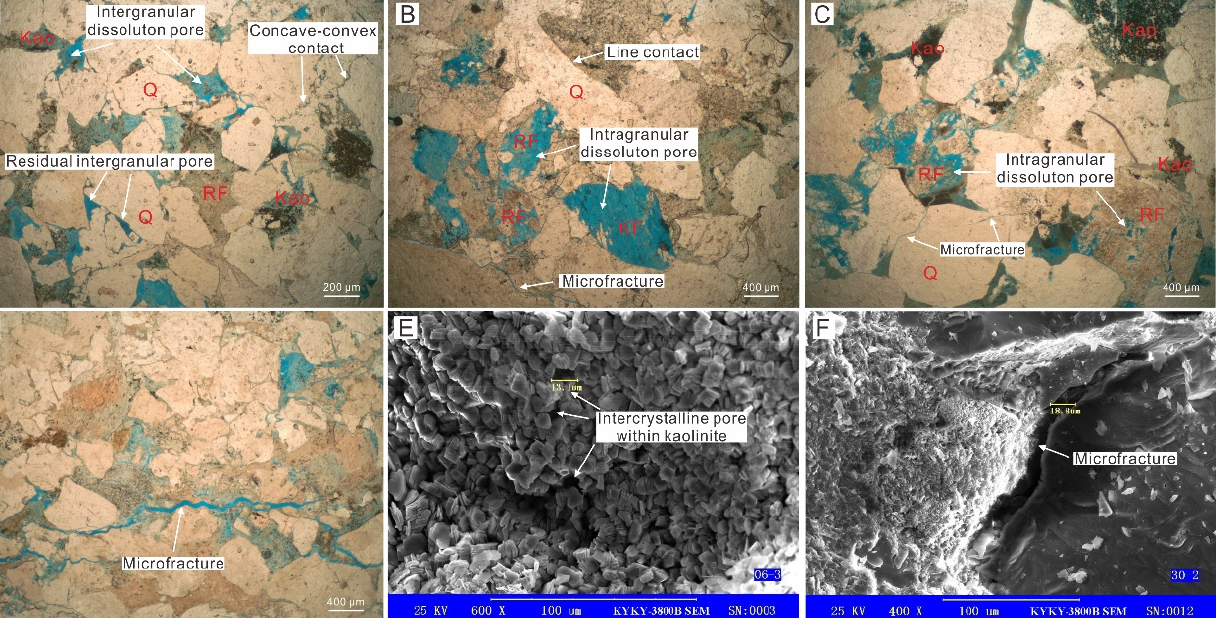
The pore types of the sandstones in Lower Shihezi Fm. are dominated by dissolution